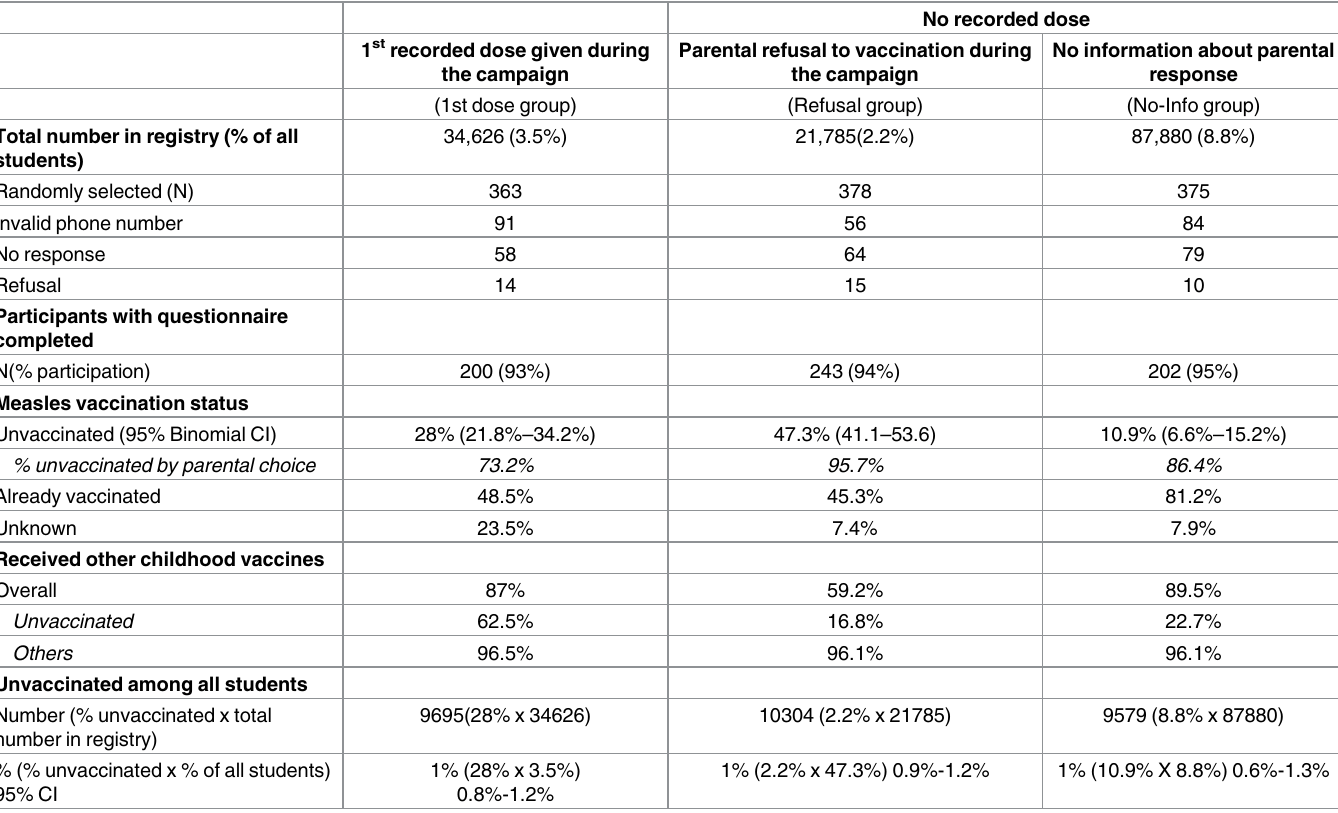
95.7% and 86.4% in the 1 st dose, Refusal and No-info groups respectively). The percentage of participants reported as unvaccinated among those living in Montreal was similar in the 1 st dose group (25%, 18/72), but much lower in the Refusal group (20%, 9/46) and in the No-info group (4%, 3/82) compared to the entire groups. The percentage reported by parents as unvac- cinated was lower among students born outside Canada than among those born in Canada: 17% vs 34% in the 1st dose group, 13% vs 52% in the Refusal group and 5% vs13% in the No- info group but the difference was statistically significant only for the No-Info group.(Fig 1)